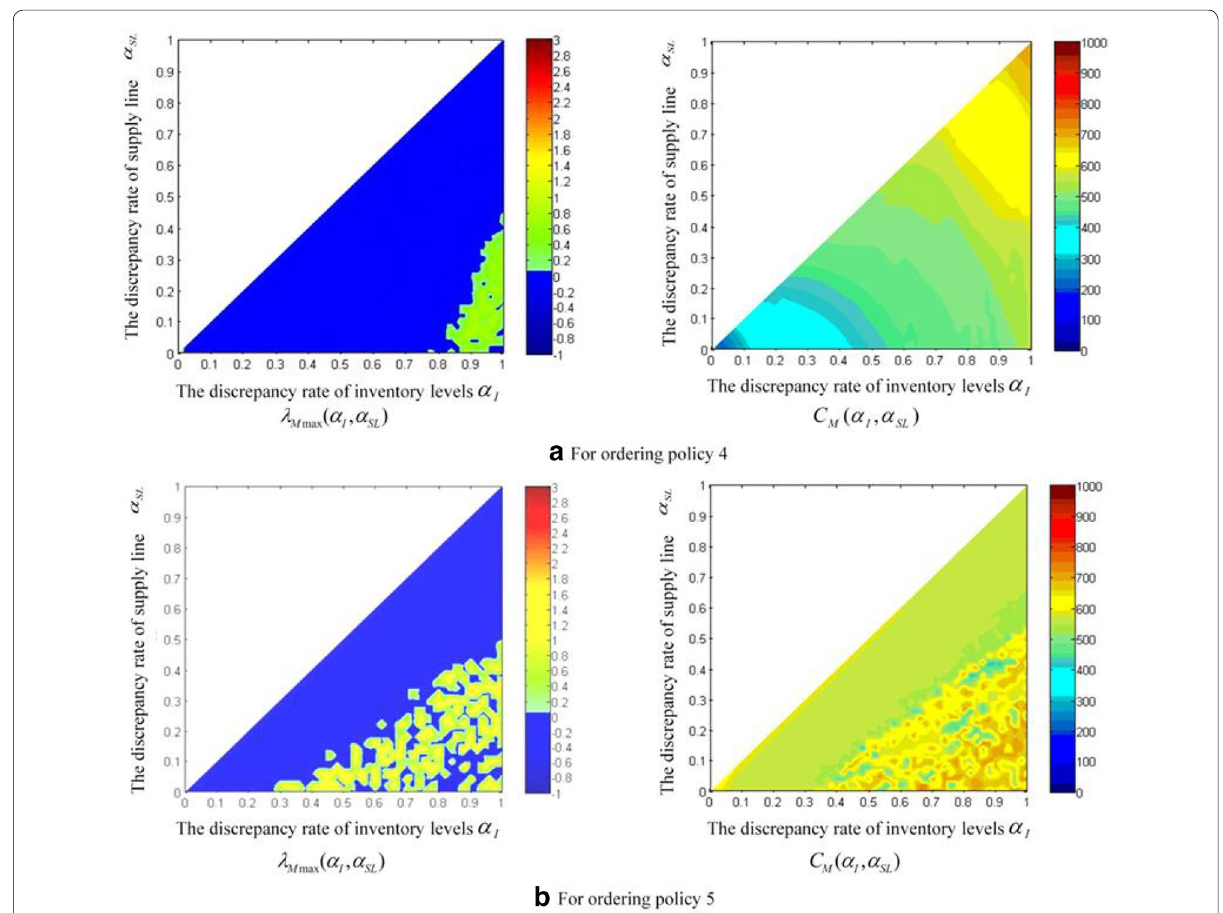
Figure 7 Distribution of (cid:31) M max and C M for the manufacturer in the case of different ordering